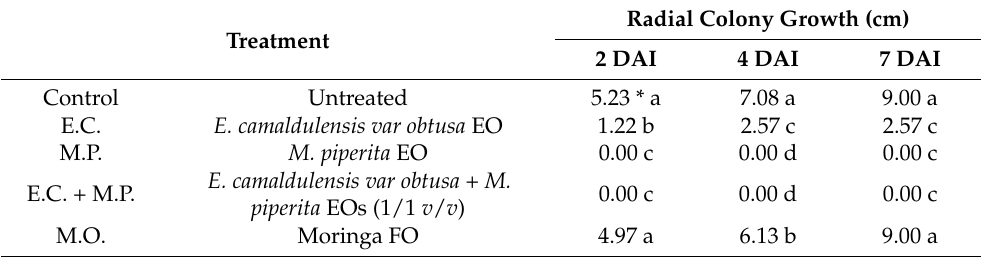
Table 5. Radial colony growth (cm) on potato dextrose agar medium with oils for Botrytis cinerea isolated from strawberry